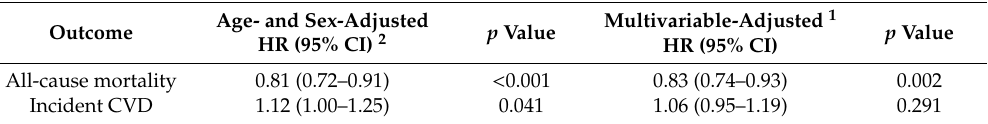
Figure 1. Kaplan – Meier curves for quartiles of homoarginine and event-free probability of survival (years). Table 3. Association of plasma homoarginine concentration with risk of cardiovascular disease (CVD) and all-cause mortality.